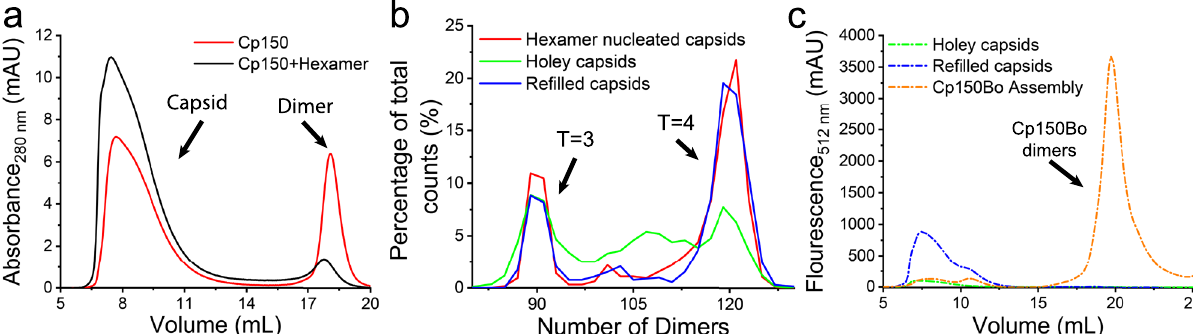
Fig. 4 Generating holey capsids through co-assembly and disassembly, and reassembling holey capsids. a SEC shows that heterodimer hexamers co- assemble with Cp150 homodimers (black) to generate more capsids than Cp150 homodimer itself (red). b RPS analysis of co-assembled capsids, holey capsids, and surface-re fi lled capsids. Puri fi ed co-assembled capsids have two major species, T = 3 and T = 4 capsids (red line). After the disassembly process, holey capsids are generated from T = 4 capsids resulting in a heterogenous array of incomplete holey capsids (green line). With the addition of Cp150Bo homodimer, the surfaces of holey capsids are re fi lled back to T = 4 capsids (blue line). c SEC with a fl uorescence detector shows that Cp150Bo co-elute with surface-re fi lled capsids. Chromatographs are shown for holey capsids (green), surface-re fi lled capsids (blue), and, as a control, Cp150Bo capsids (orange). It is noteworthy that the BODIPY fl uorescence in the capsids of pure Cp150Bo is quenched.